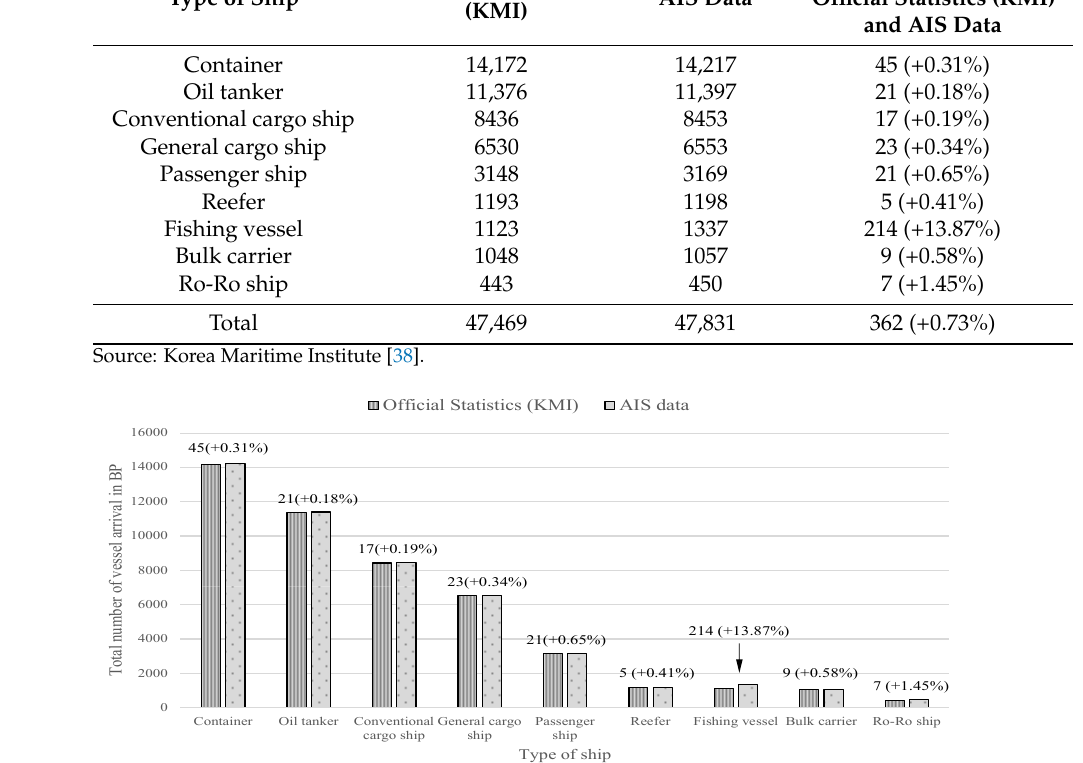
Table 2. Vessel arrivals of different types in BP in 2019.